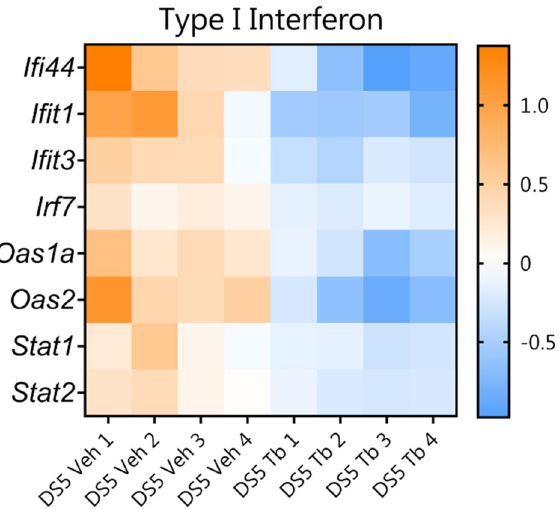
Figure 4. Heatmaps showing that oral tributyrin treatment (Tb) reduces expression of Type I interferon (IFN) signaling genes in conjunctiva. Expression analysis using the NanoString Mouse Inflammation panel v2 was performed on conjunctival tissue from mice subjected to DS with vehicle (Veh) or with tributyrin treatment. For all genes identified as significantly changed, log2 > 1.2 and p adj. <